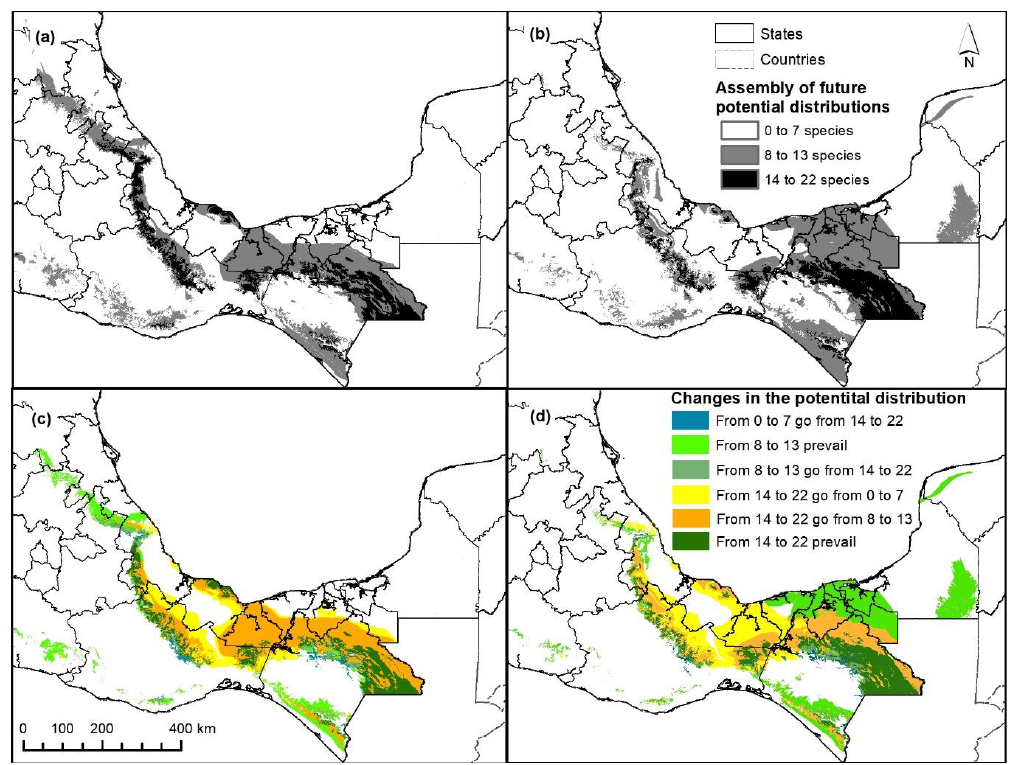
Figure 7. Assembly map of the projected future potential distribution ( a ) HADGEM2_ES and ( b ) GFDL_CM3 climate change scenarios. Potential distribution change by class in ( c ) HADGEM2_ES and ( d ) GFDL_CM3 scenarios.